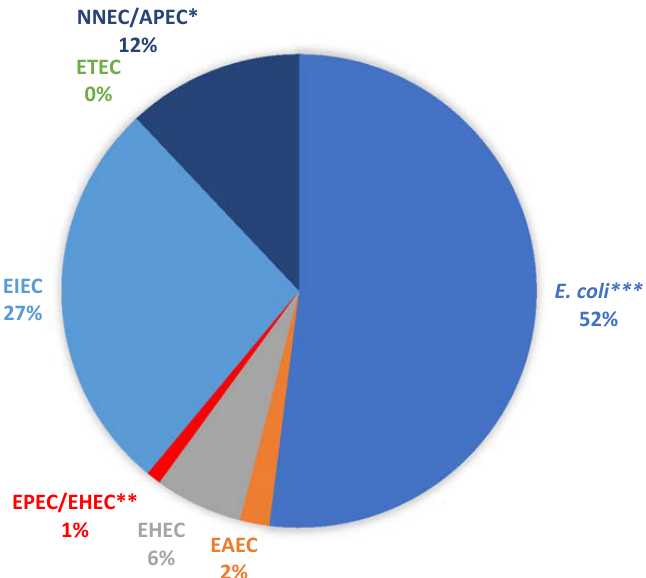
Figure 1. Percentage detection of the various E. coli pathotypes. * NNEC/APEC: positive for the ibeA gene, which is present in both Avian Pathogenic E. coli (APEC) and NMEC (Neonatal Meningitis-Associated E. coli ). ** EPEC/EHEC (Enteropathogenic E. coli /Enterohaemorrhagic E. coli ): positive for the eaeA gene, which is present in both pathotypes. *** E. coli denotes all isolates that were not positive for any of the Virulence Genes tested.